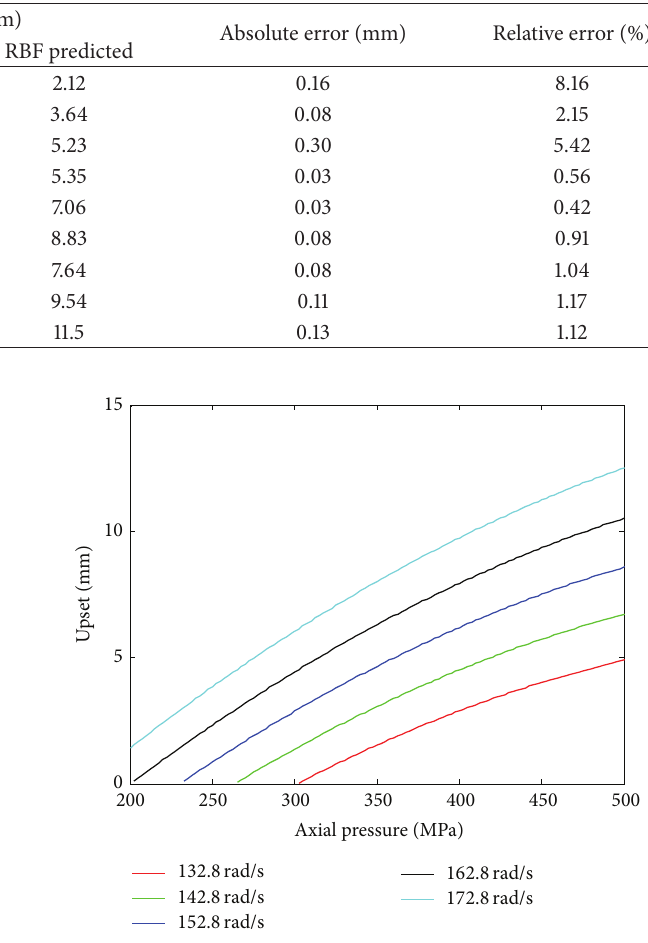
Figure 8: Effect of square of initial rotational speed on upset predicted by RBF network.